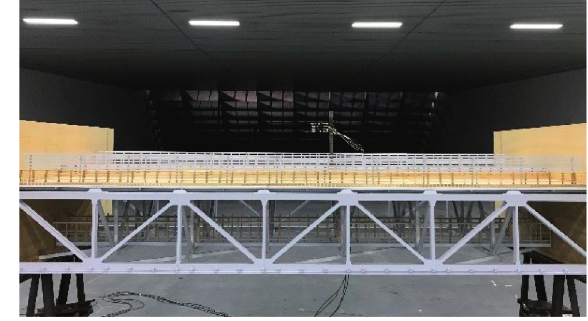
Figure 4: Model placed in the wind tunnel.